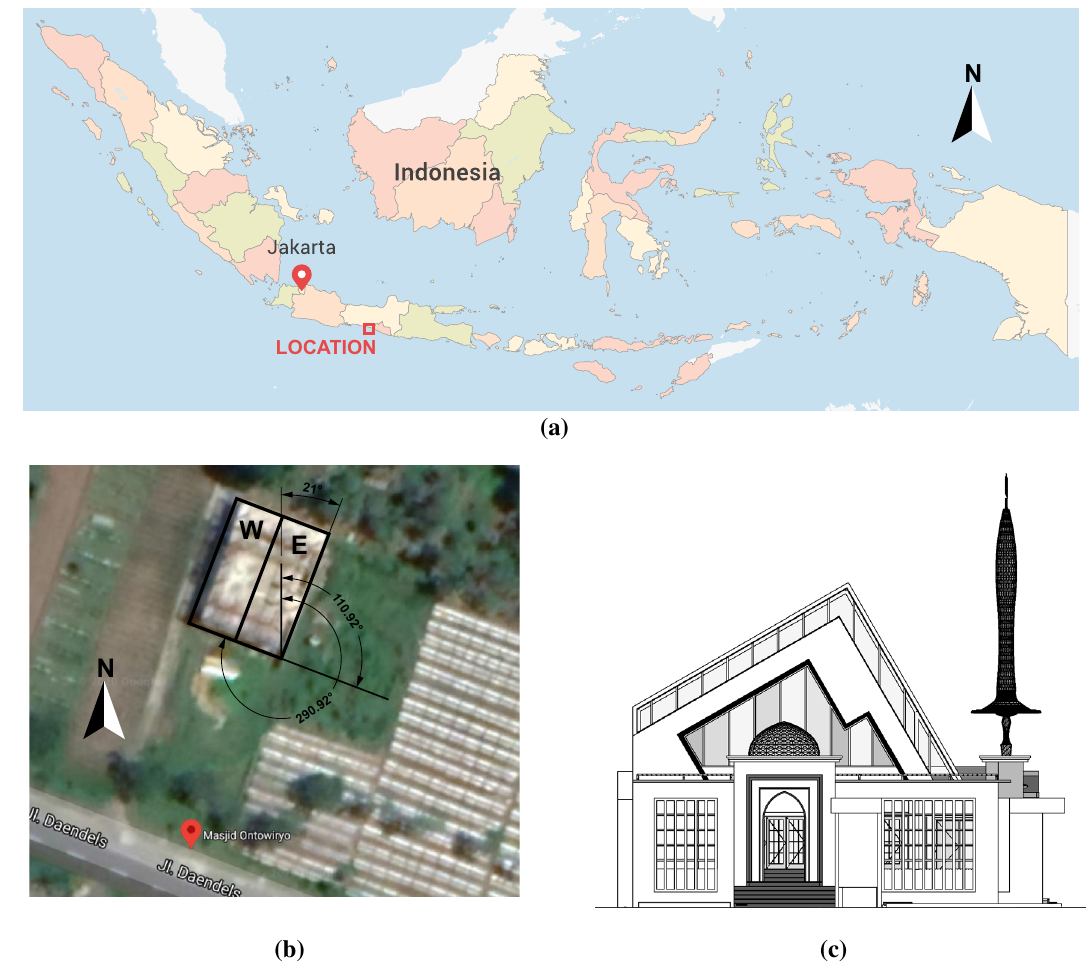
Figure 1. ( a ) Indoesia Map showing the location of the Ontowiryo Mosque, modoified from FreeVectorFlags. com with CorelDRAW 2018 41,42 , ( b ) Google maps image showing the mosque that is facing south-west. The mosque roof has two sides, west (W) and east (E). Image is modified with CorelDRAW 2018 42 , ( c ) The South Façade adapted from the mosque’s Detailed Engineering Design 43 .